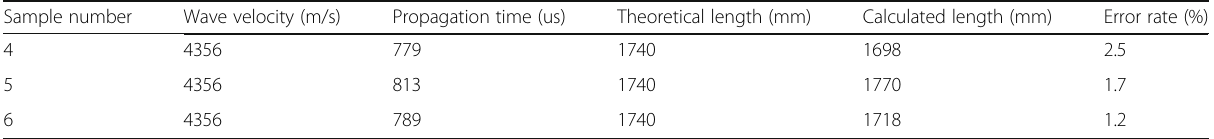
Table 3 Statistical table of the hollow grouted rock bolt free length for samples 4#, 5#, and 6# Sample